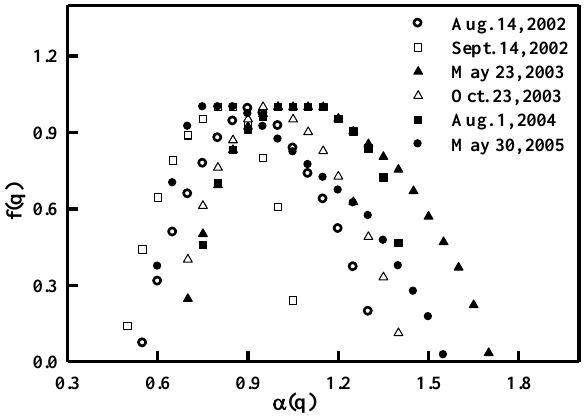
Fig. 4. The mass exponents of the six soil water storage series ( q = − 20 to 20 at 1.0 increments). The solid line is a linear reference created following the UM model of Schertzer and Lovejoy (1987) passing through τ ( q = 0).